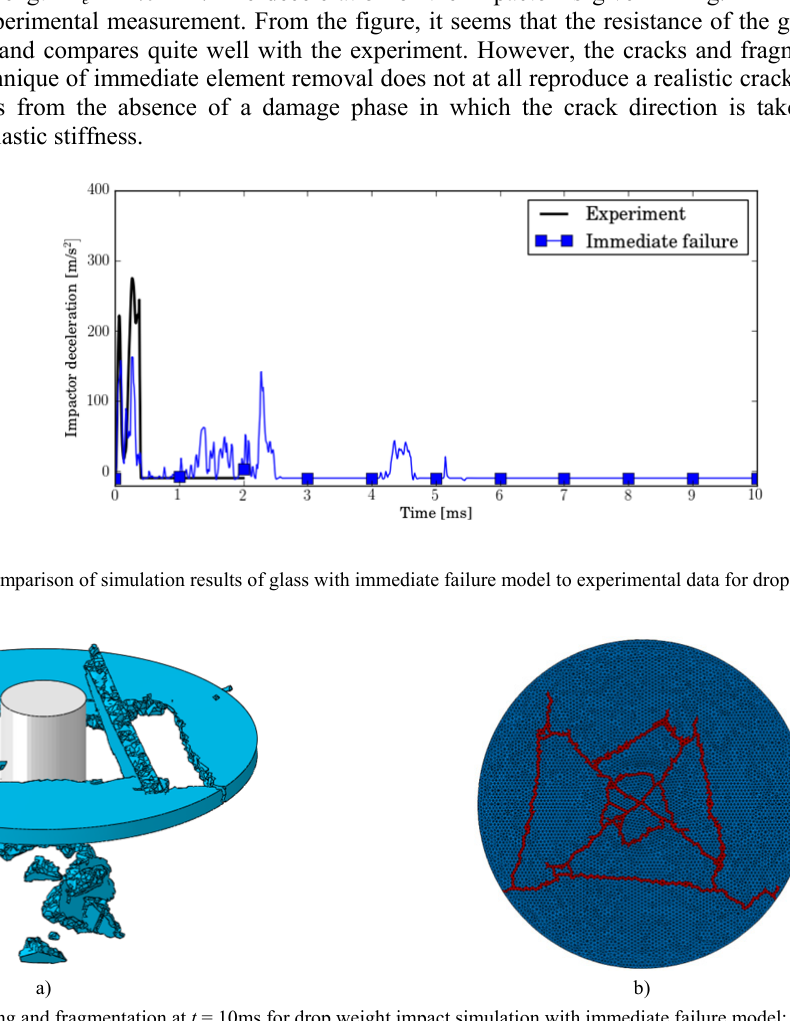
Fig. 13 Glass cracking and fragmentation at t = 10ms for drop weight impact simulation with immediate failure model; a) perspective view, b) bottom view of failed